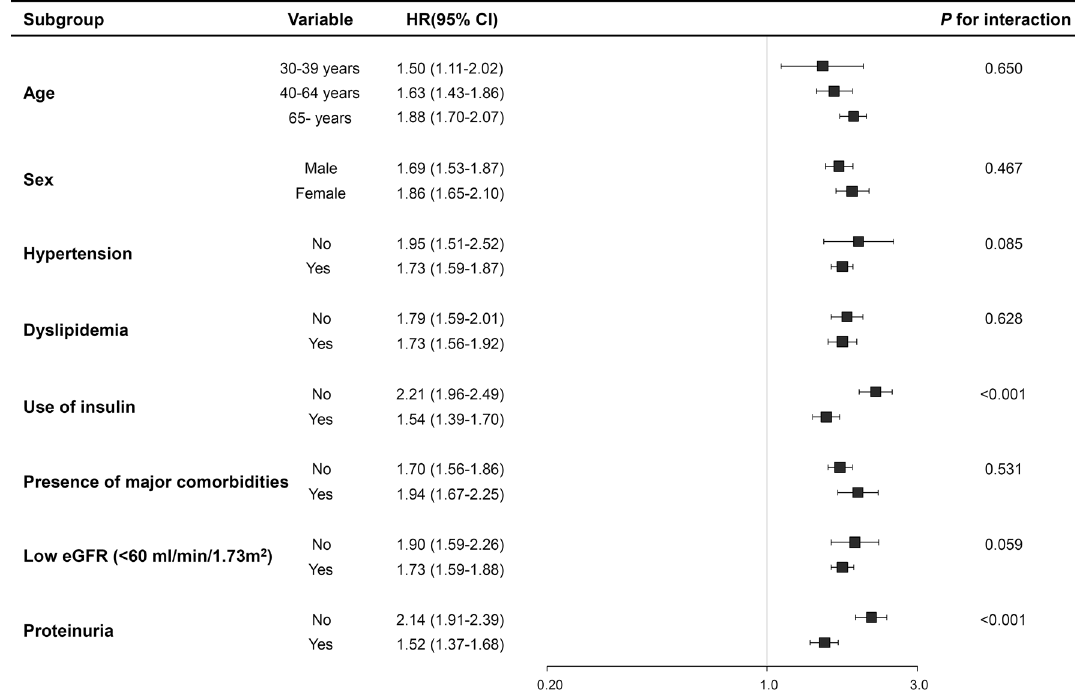
Figure 2. Subgroup analysis for the association between recurrent severe hypoglycemia and end-stage renal disease. All HRs adjusted for covariates including age, sex, smoking, alcohol consumption, regular exercise, living place (urban or rural), income level, BMI, hypertension, dyslipidemia, chronic kidney disease, urine protein, anti-diabetic drugs, diabetes duration, fasting plasma glucose, LDL-cholesterol, and major comorbidities (malignancy, liver cirrhosis, and chronic obstructive pulmonary